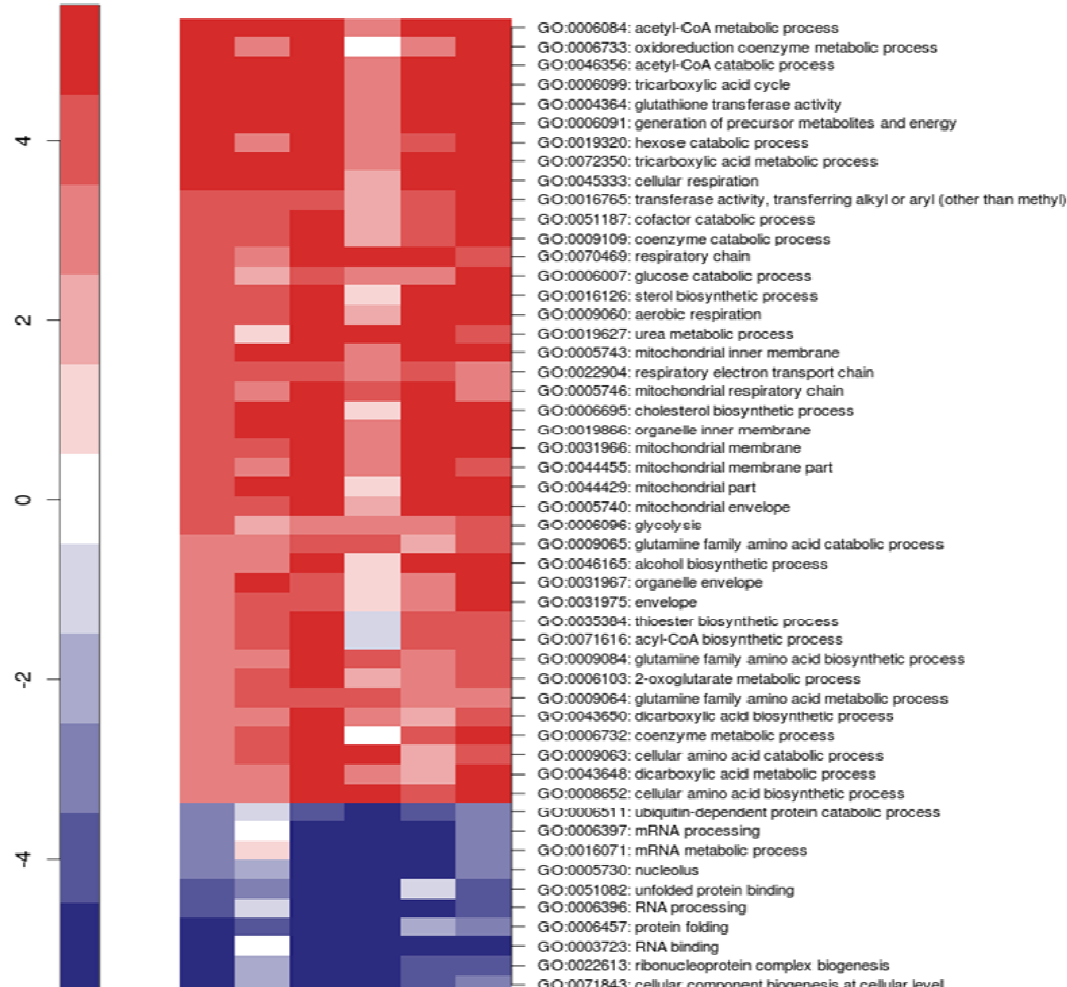
Figure 3. Common pathways for liver CR in multiple mouse strains. Parametric analysis of gene set enrichment (PAGE) identified gene sets significantly modulated by CR ( p < 0.01, FDR < 0.15) in liver for at least five of the six strains. Each row corresponds to the transcriptional alteration of each gene set with CR. Gene sets up-regulated with CR are shown in red, whereas gene sets down-regulated with CR are shown in blue. Labels indicate the GO ID and GO term of each